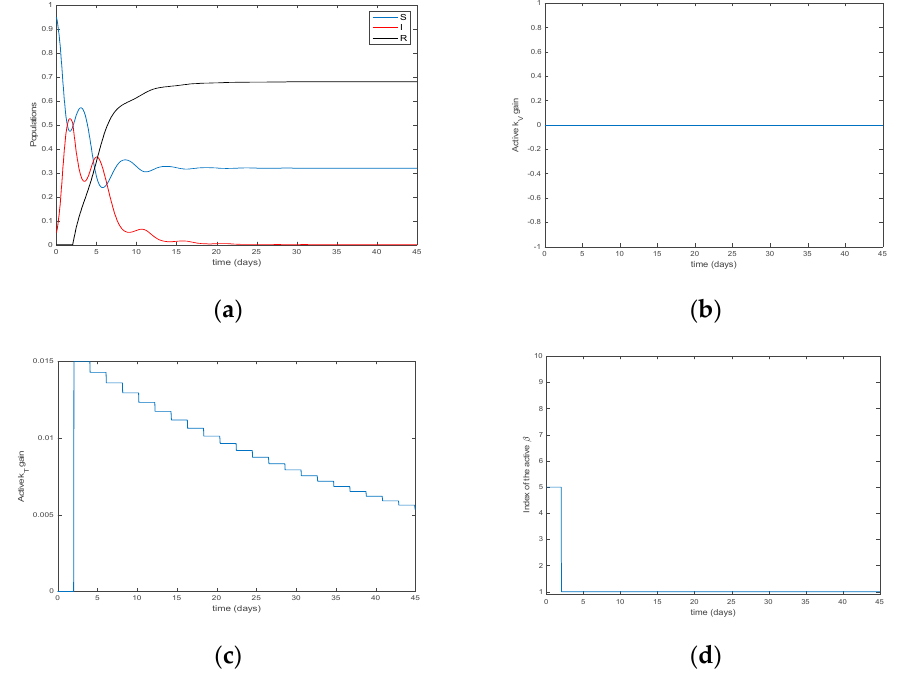
Figure 8. Performance of the system with seasonal incidence rate and vaccination and treatment actions tuned by Algorithm 3. ( a ) Evolution of model’s populations. ( b ) Active gain from S KV parameterizing the vaccination action. ( c ) Active gain from S KT parameterizing the treatment action. ( d ) Index representing the active model from S β parameterizing the transmission rate.